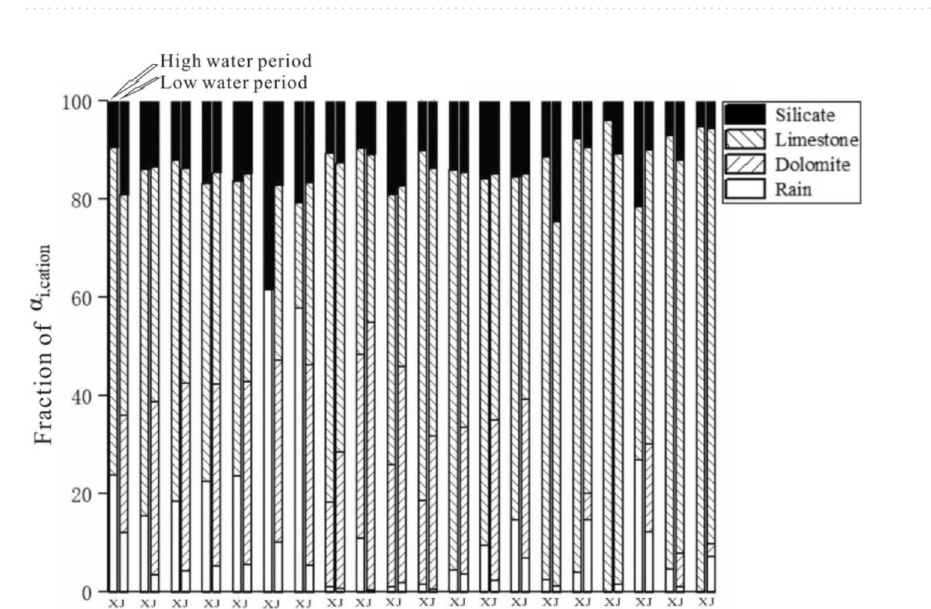
Figure 10. The fraction of total dissolved cations (α i,Catin = α i,Ca + α i,Na + α i,Mg + α ,K ) from rainfall, dolomite, limestone, and silicate. Two bars for the high (left) and low-water period (right) represent each sampling point, as indicated for sample